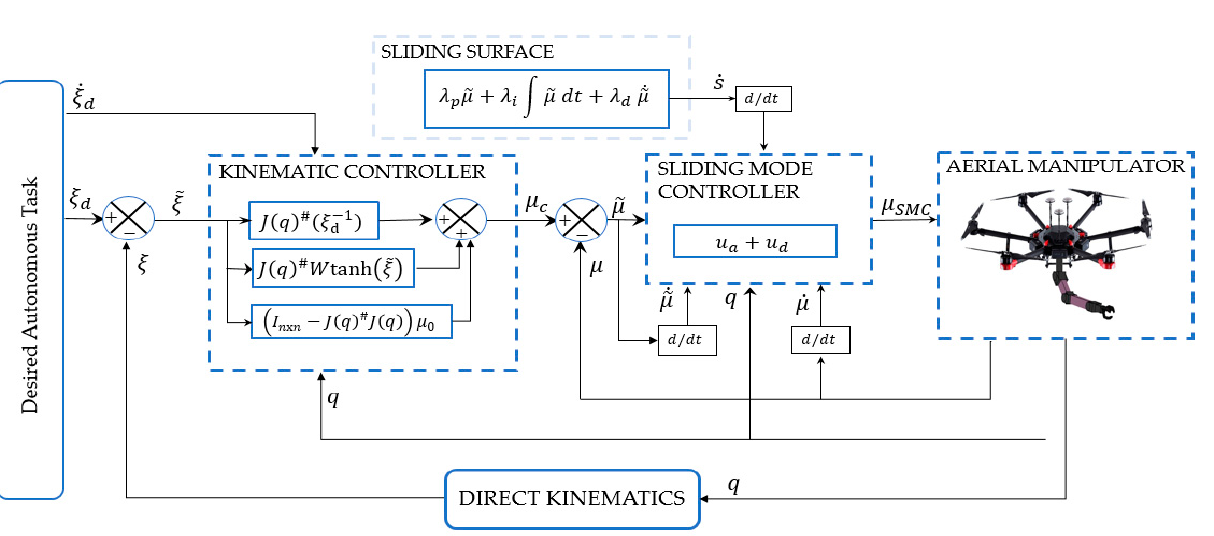
Figure 4. Sliding Mode Controller scheme.